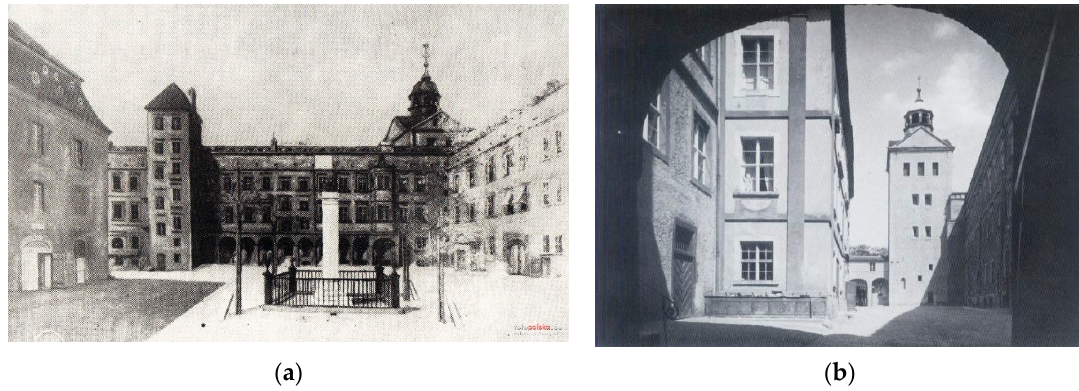
Figure 3. ( a ) The main courtyard of the castle after the reconstruction of the southern wing (left) and the demolition of the cloisters in the northern wing, source: fotopolska.eu; ( b ) mint courtyard and a view of the new avant-corps in the museum wing, source: sedina.pl.